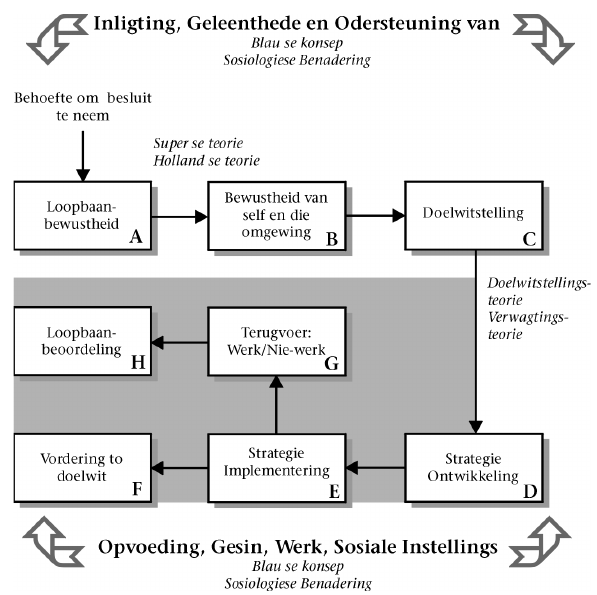
Figuur 1: Loopbaanbeplanningsmodel van Greenhaus & Callanan (1994) met geïntegreerde teorieë